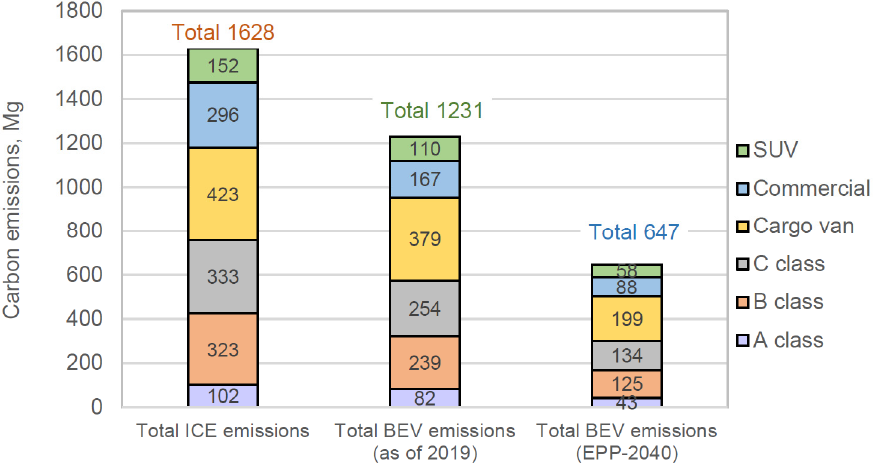
Figure 7. Comparison of total emission levels for ICE and BEV vehicle categories (Mg).